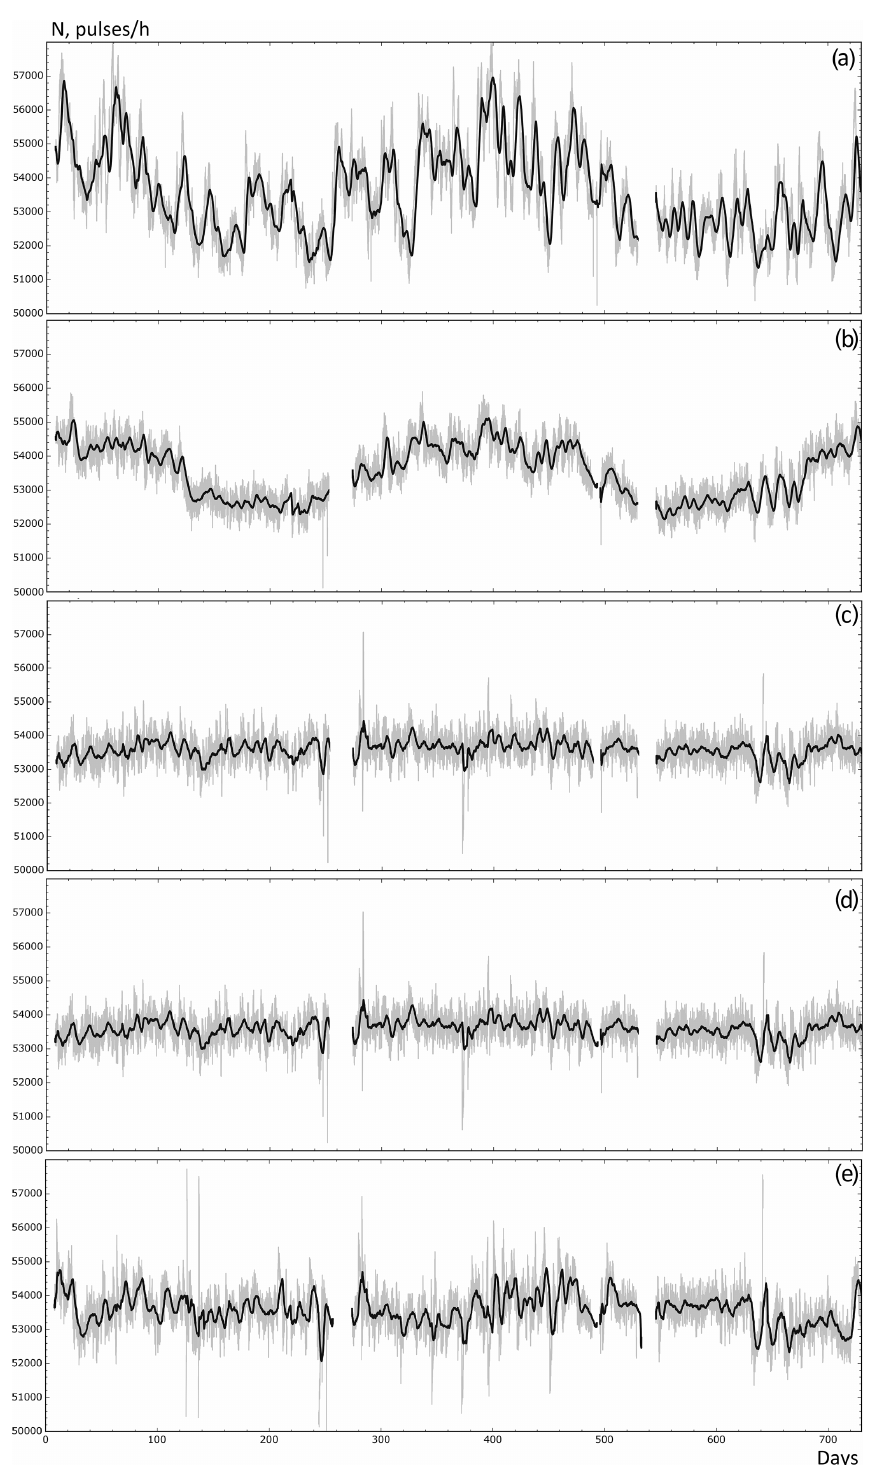
Figure 4. Count rate variations of the CARPET-MOSCOW installation for the period of 2020–2021: (a) uncorrected data, (b) pressure- corrected data, (c) pressure- and temperature-corrected (negative effect applying the effective generation method) data, (d) pressure- and temperature-corrected (negative and positive effect applying the effective generation method) data, (e) pressure- and temperature-corrected (the integral method) data. Grey lines indicate initial data, and black lines indicate data with averaging by 24 points.